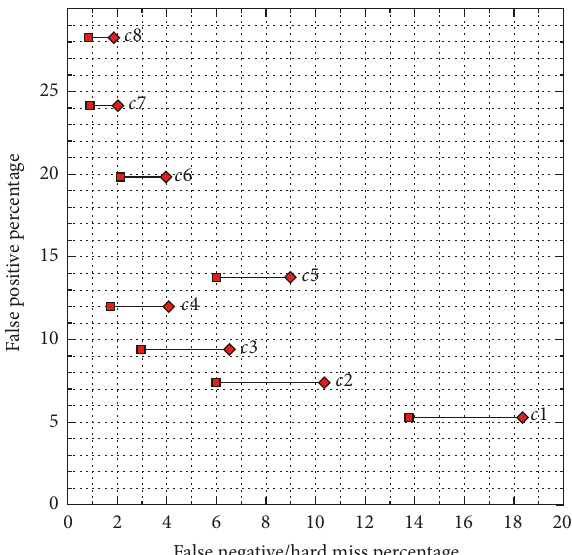
Figure 5: Trade-off between false positives and false negatives on the A58. Diamonds indicate the false negative percentages while the squares denote the hard miss percentages.